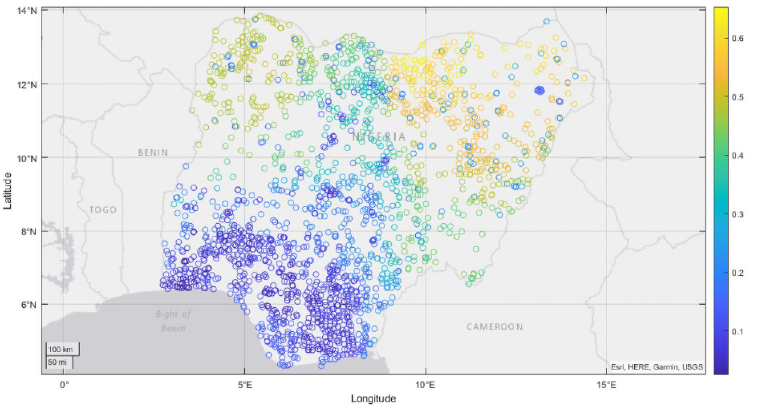
Fig 2. Mean nowcasts for asset poverty prevalence for Nigeria, 2013. Within survey r 2 is 0.56.